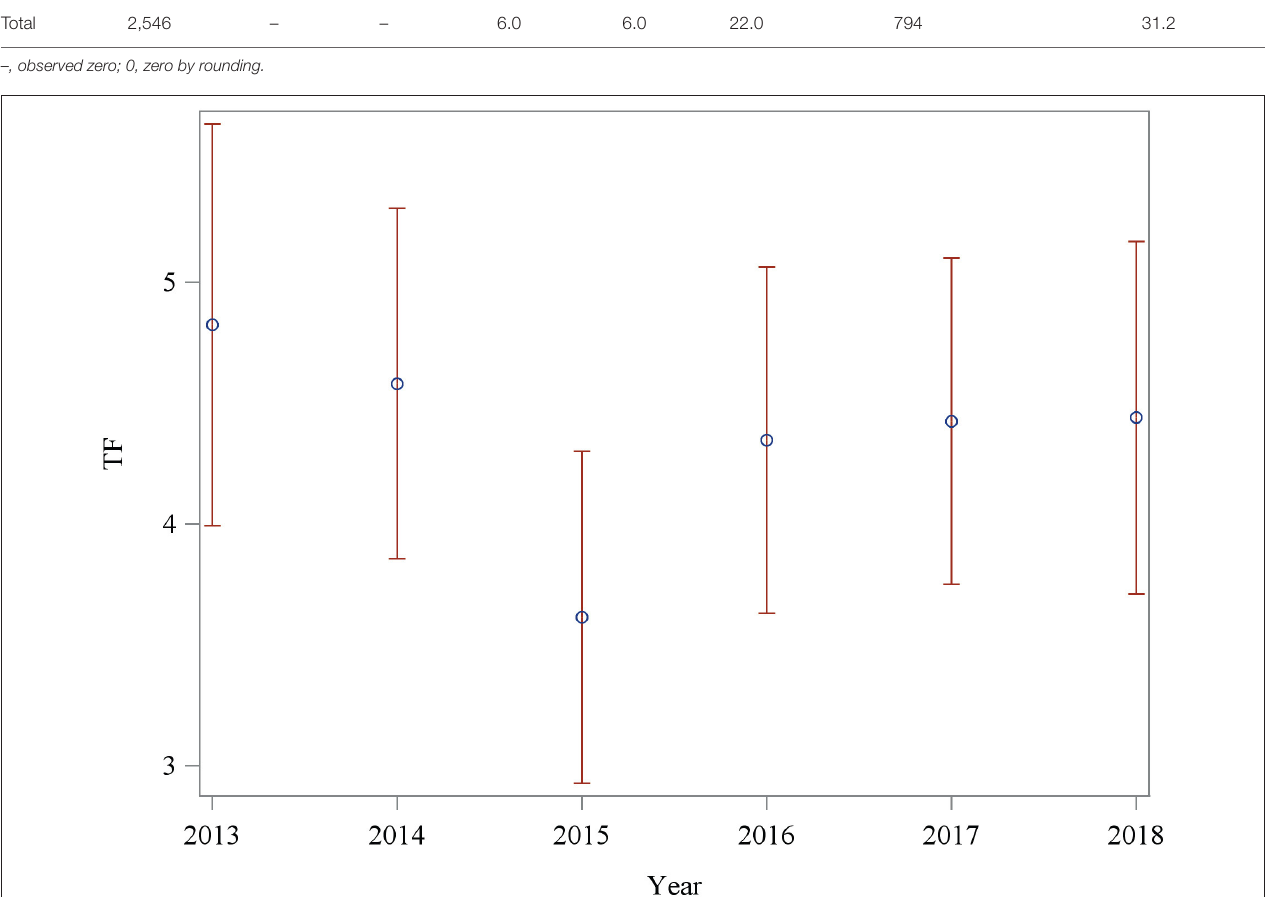
FIGURE 1 | Estimated means of the TF over the years 2013–2018 with 95% confidence intervals.